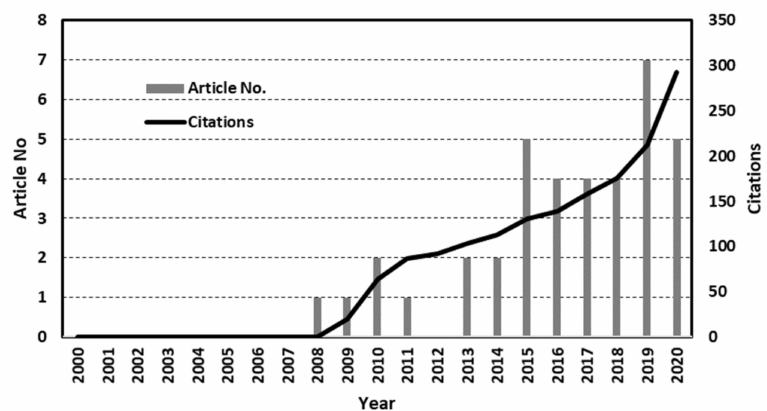
Figure 14. Number of articles (Article No.) on reduction reactions and related citations regarding PMRs from the year 2000 to 2020 documented in the Scopus database (keywords: “photocatalytic membrane reactor” or “membrane photoreactor” or “photocatalytic membrane” and “reduction” or “hydrogenation” and